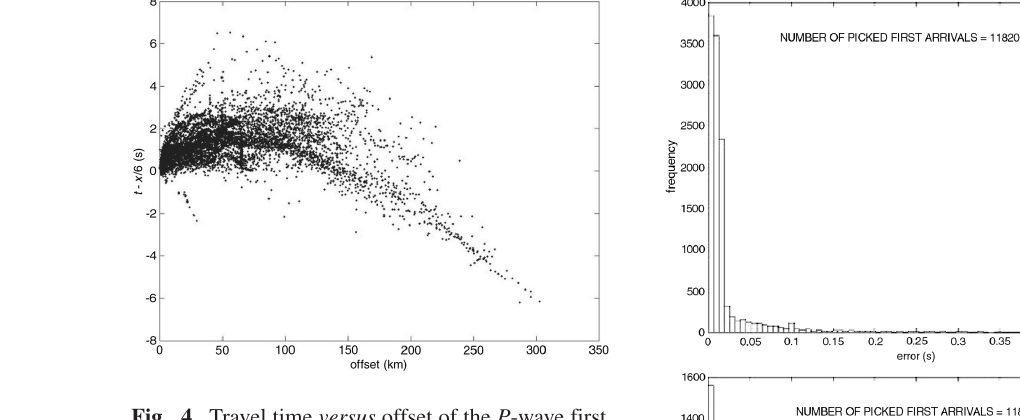
Fig. 4. Travel time versus offset of the P -wave first arrivals with reduction velocity 6 km/s.